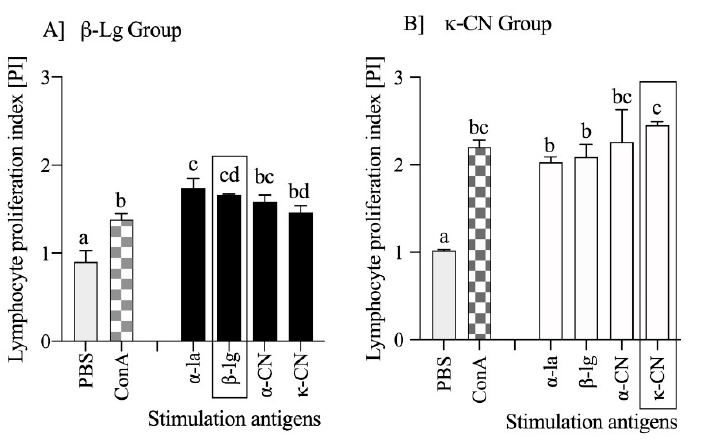
Figure 5. The effect of major milk antigens (dose 200 µ g/mL) on splenocytes sensitized in vivo to